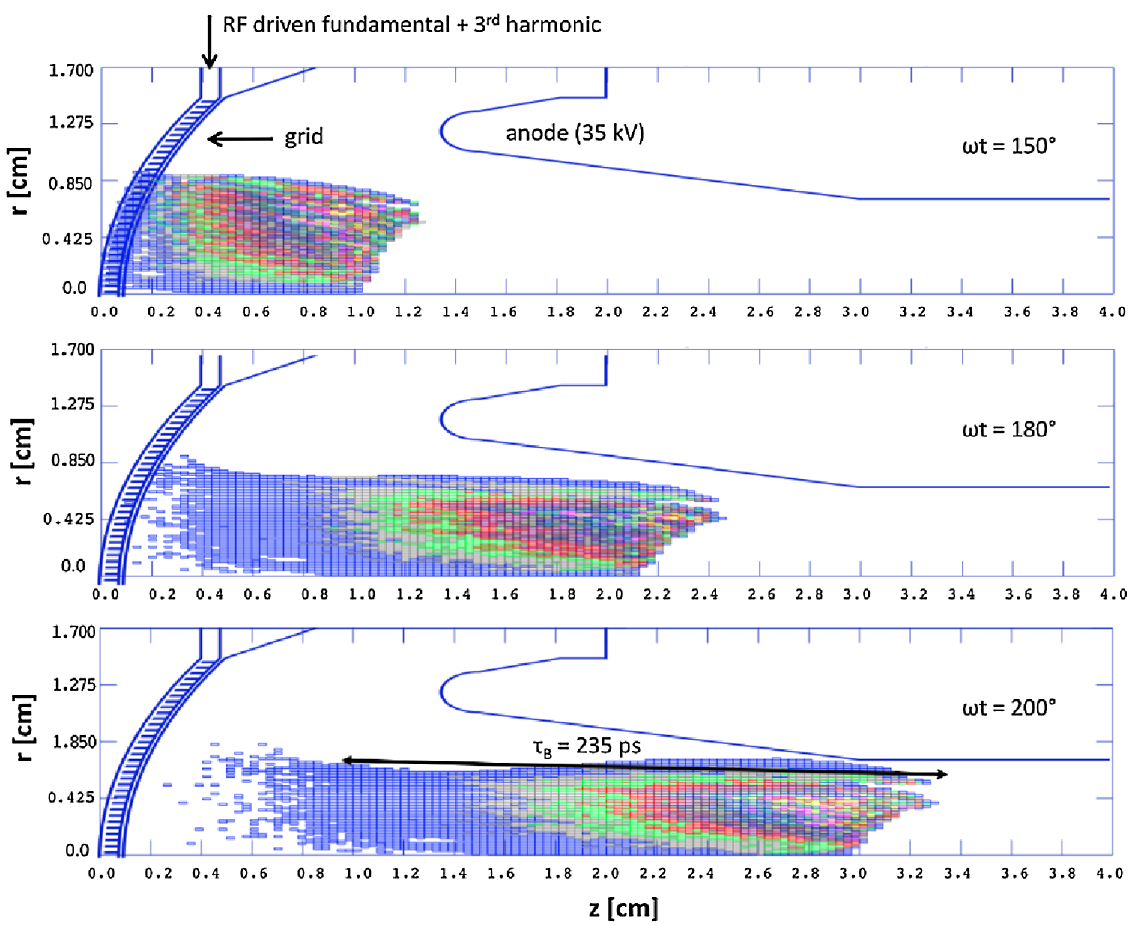
FIG. 20. PARMELA simulation of the rf-gated, gridded thermionic gun illustrated in Fig. 19 (compare Fig. 17). The plots show the generation of a 1 nC electron bunch with end-to-end duration of 235 psec and a normalized emittance of 16 mm mrad. The rf phase !t is indicated in each figure.